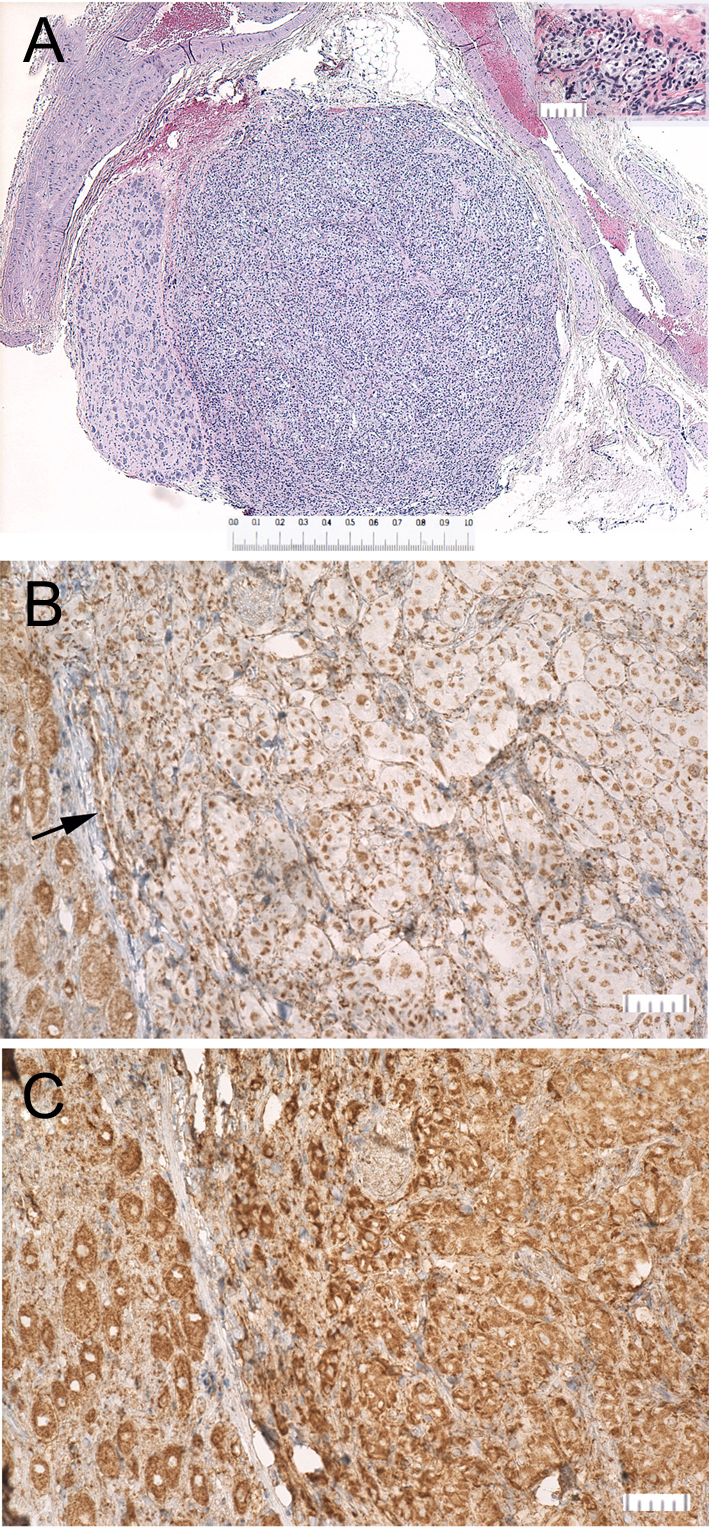
Carotid body paraganglioma. (A) Carotid bifurcation containing a paraganglioma (center) and adjacent superior cervical ganglion (left); Bar = 1 mm. Inset shows the entire normal carotid body from an 18-month-old Sdhb+/- rat (Bar = 50 um). (B) Immunohistochemical stain for SDHB showing loss of granular cytoplasmic staining in tumor cells and retained dark granular staining in endothelial cells (arrow) and SCG neurons. (C) Tumor cells, neurons and endothelial cells show granular staining for SDHA.